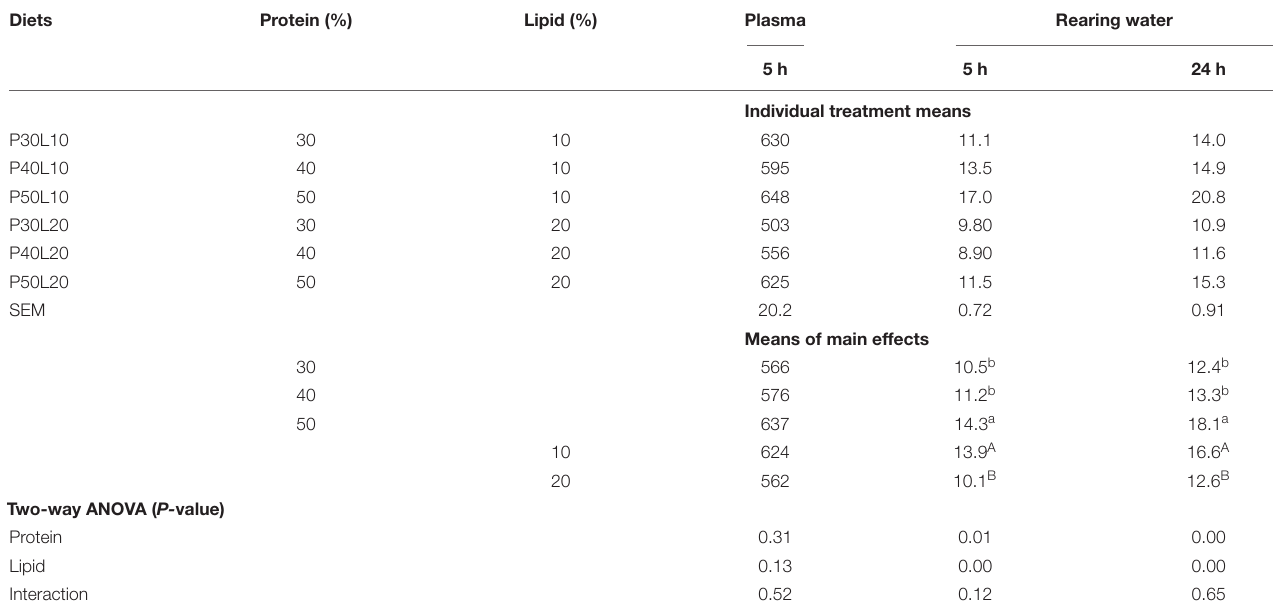
Diets Protein (%) Lipid (%)